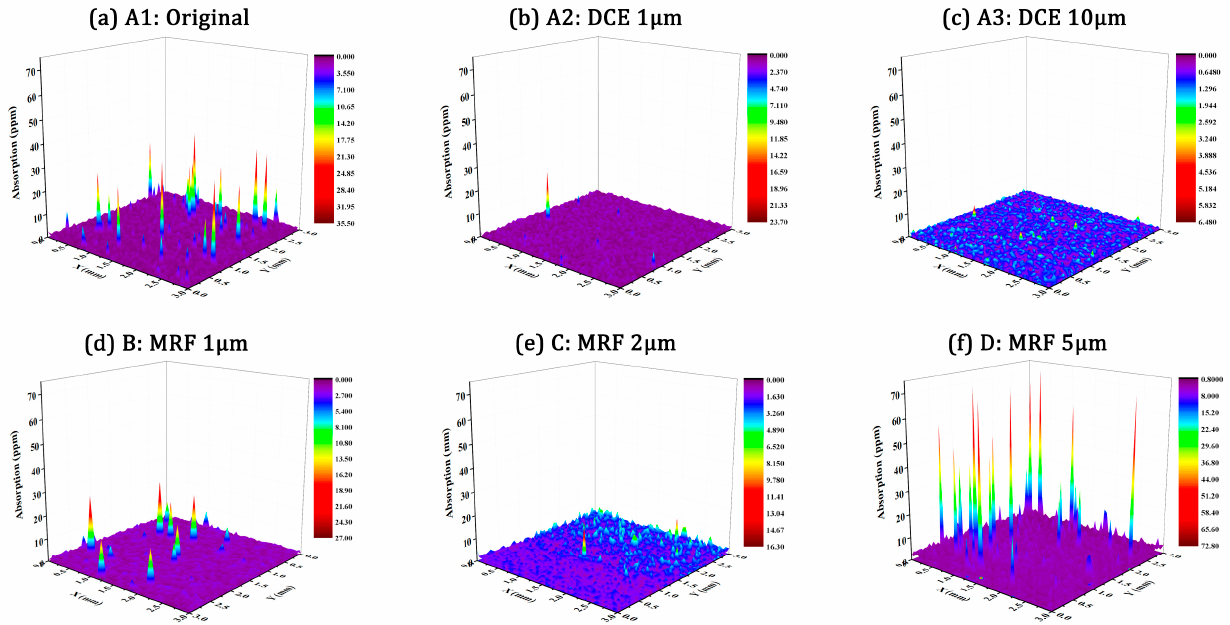
Figure 2. Weak absorption mapping at 355 nm of sample surfaces. Each scan area size was 3 mm × 3 mm with the detecting step of 50 μ m. The X and Y axes represent position information, and the Z- 3 mm × 3 mm with the detecting step of 50 µ m. The X and Y axes represent position information, axis represents the surface absorption intensity of fused silica optics. and the Z-axis represents the surface absorption intensity of fused silica